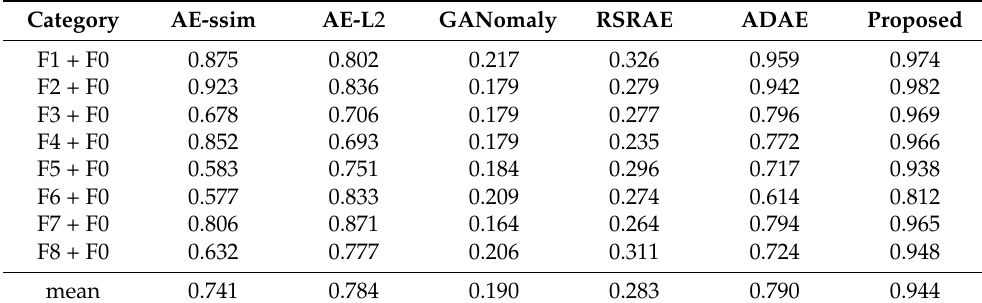
Table 5. Quantitative comparisons with other method (F1 score).